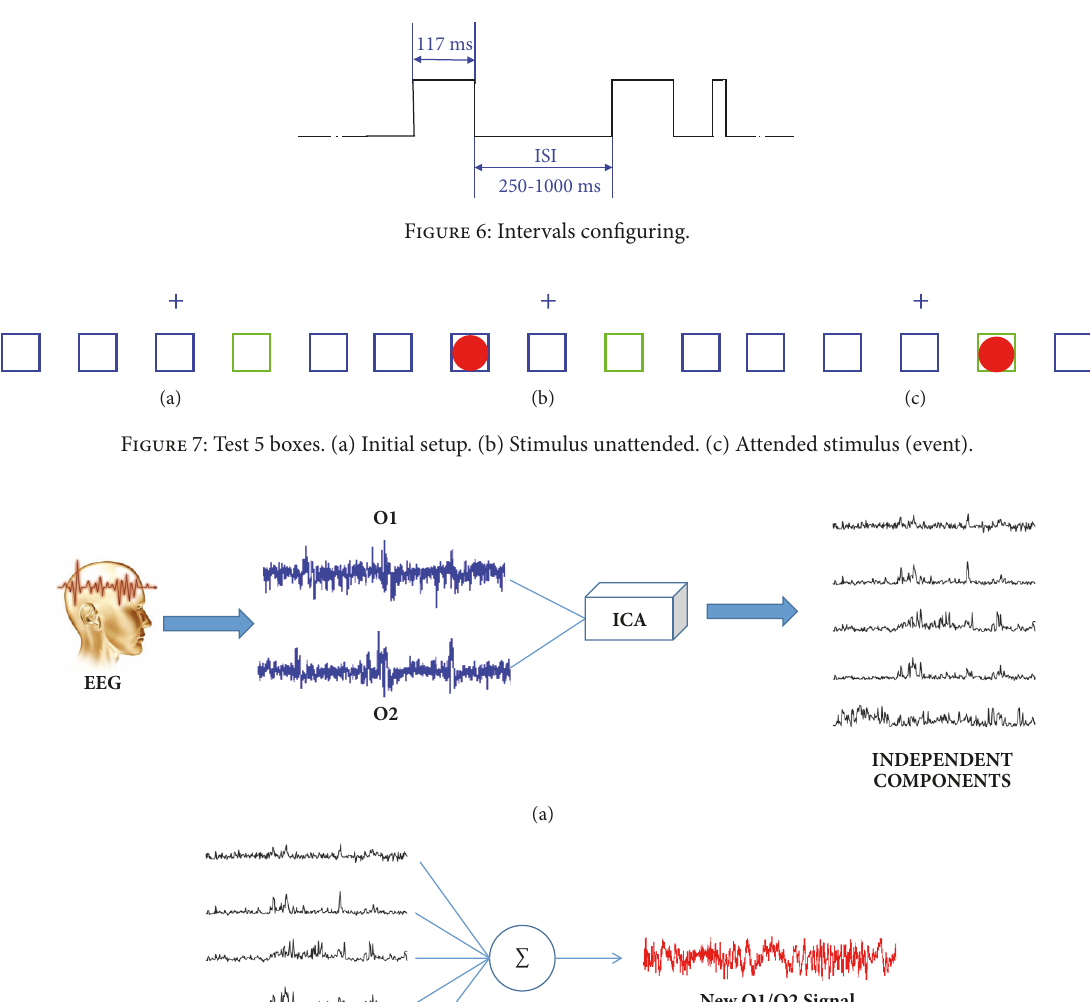
Figure 6: Intervals configuring.